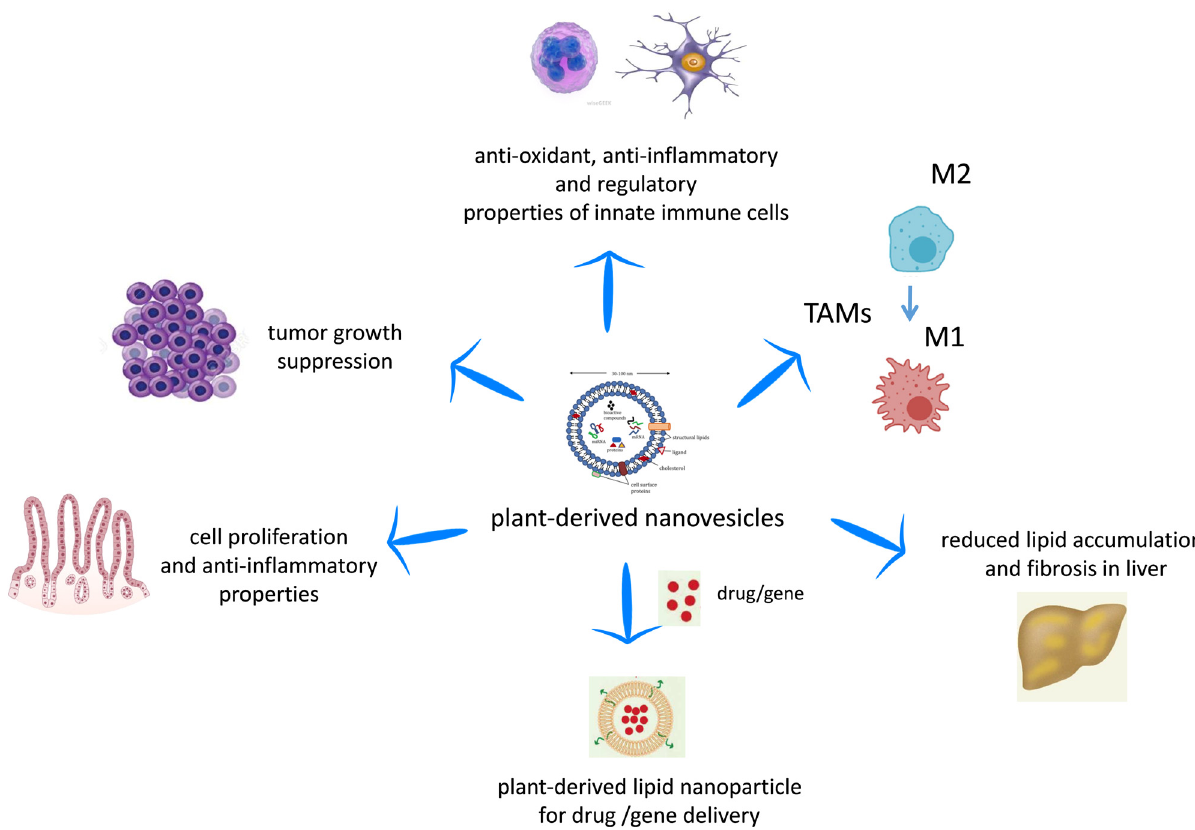
Figure 1: Biological properties of PDNVs. PDNVs can regulate in vitro and in vivo the function of macrophages and dendritic cells by inducing anti - in fl ammatory and regulatory functions, as well as shifting tumor - associated macrophages ( TAMs ) from a M2 to a M1 phenotype. PDNVs have been demonstrated to participate in intestinal tissue homeostasis in in vivo animal models and have validated functions against in fl ammation - related diseases and cancers. Finally, the e ffi cacy of PDNVs for gene or drug delivery has been